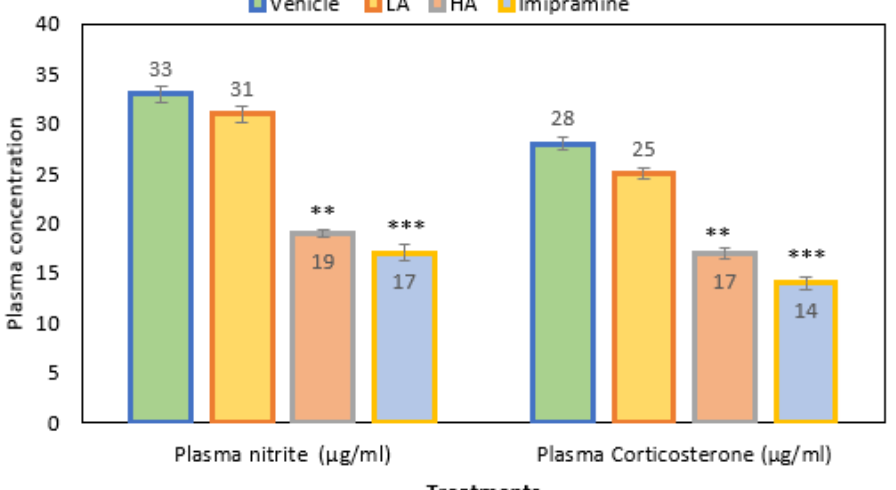
Figure 4. The effect of apigenin and imipramine changes on plasma nitrite and corticosterone levels. Data are expressed in mean ± SEM (n = 8). Data were evaluated using a one-way analysis of variance